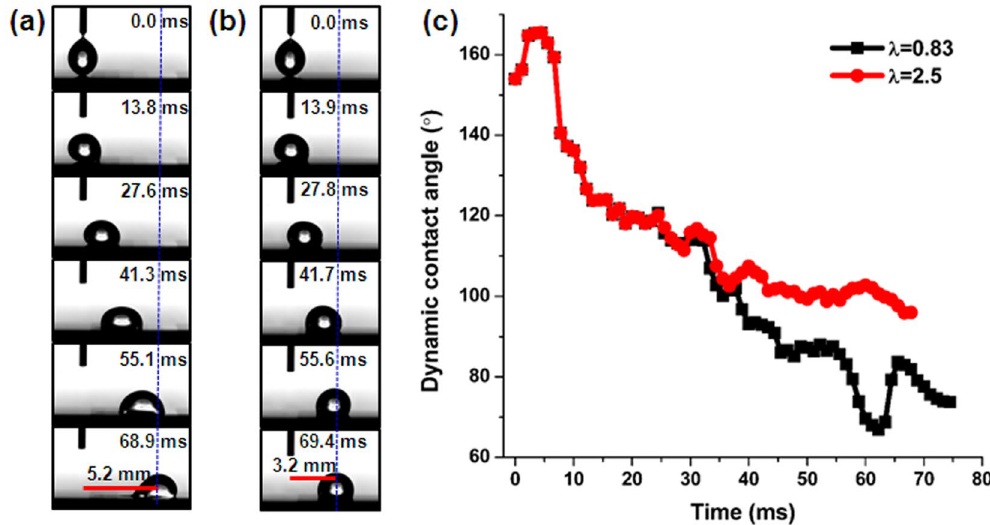
Figure 3. Time-resolved images of a 7 μ L water droplets spontaneously moving along surfaces with different λ (ratio of stripe length and droplet radius). ( a ) λ = 0.83. ( b ) λ = 2.5. ( c ) The variation of dynamic contact angle as a function of